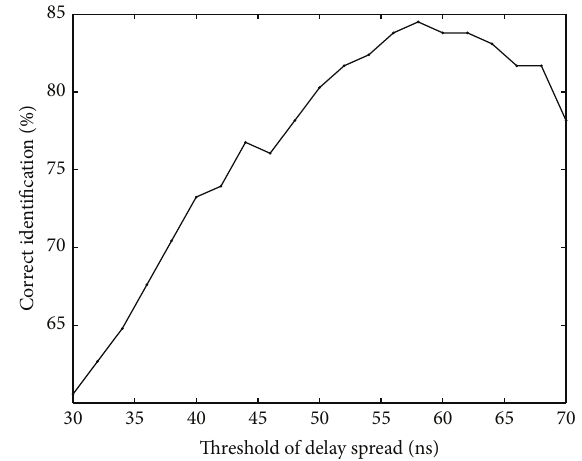
Figure 14: Percentage of correct identification versus the threshold of delay spread.